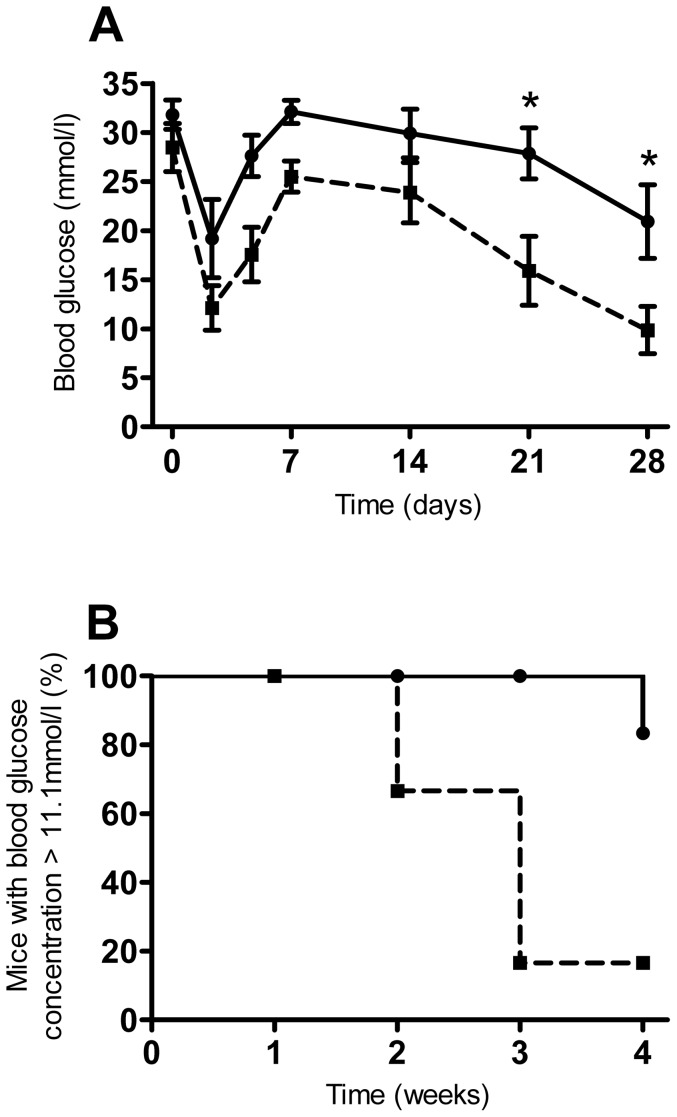
Efficacy of pelleted and manually dispersed islets in vivo.A. Blood glucose concentrations of mice with pelleted (continuous line) or manually dispersed islet transplantation (dashed line), *p<0.05, Two-Way RM ANOVA with Bonferroni post hoc test, n = 6 for both transplant groups. B. Percentage of mice remaining diabetic (blood glucose concentration >11.1 mmol/l) after transplantation as in A, p = 0.02 Kaplan–Meier, n = 6 for both transplant groups.